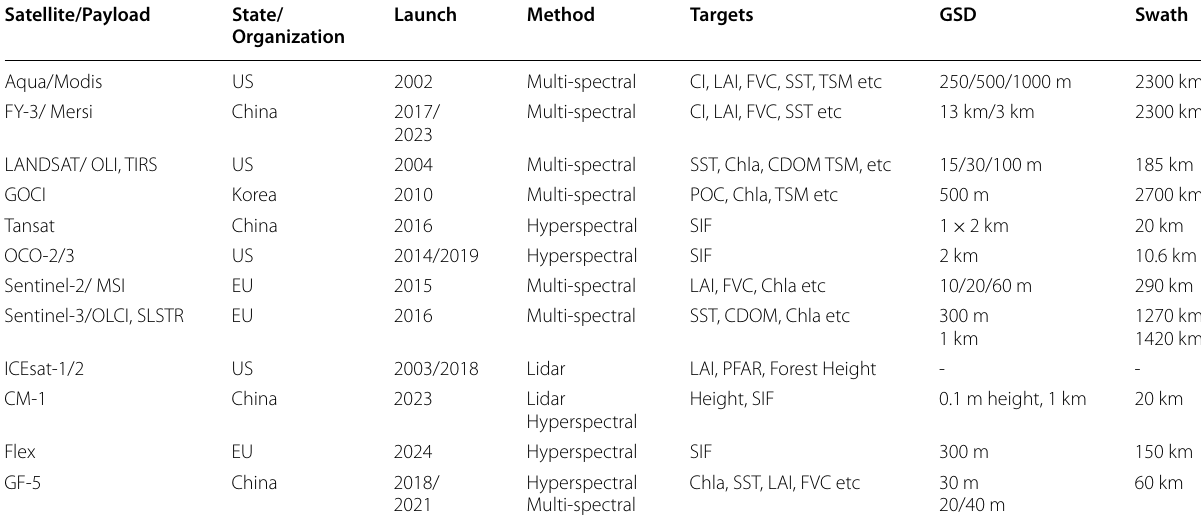
Table 4 Major specification of typical carbon sink monitoring